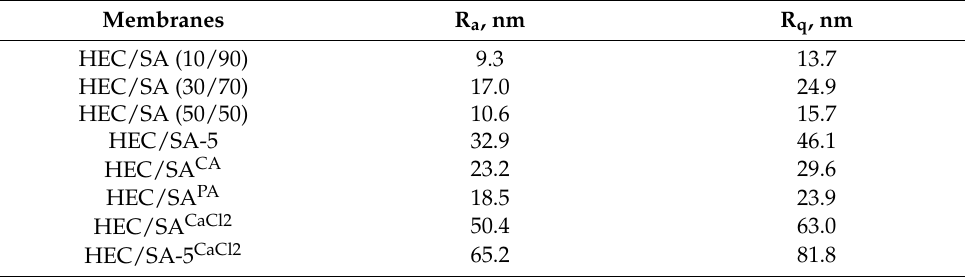
Table 4. Surface parameters of the HEC/SA membranes. Membranes R a , nm R q ,